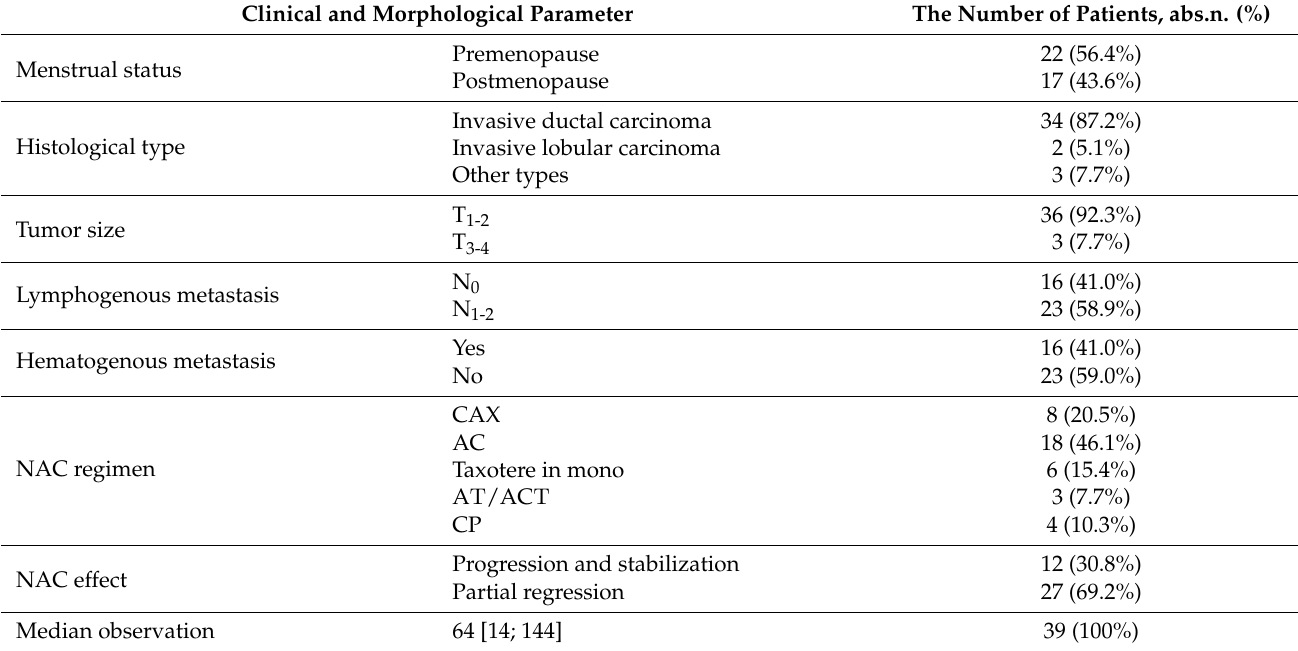
Table 4. Clinical and morphological parameters of the patients with breast cancer. Clinical and Morphological Parameter The Number of Patients, abs.n.